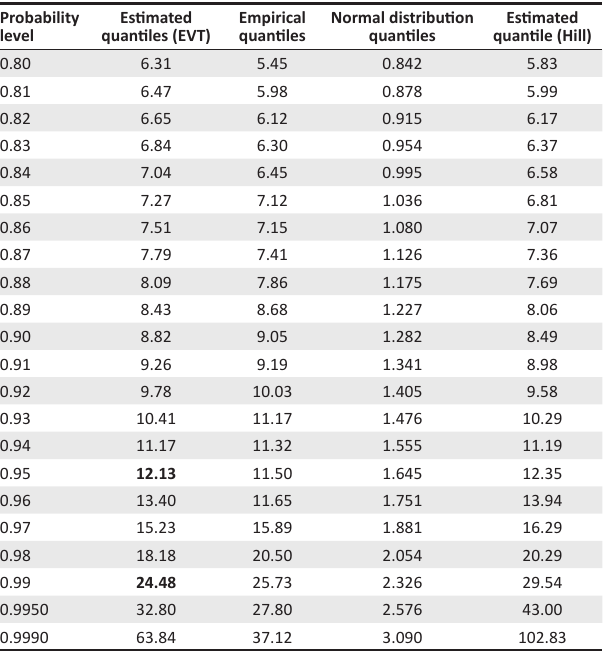
TABLE 7: South Africa – Estimated tail quantiles of the exchange market pressure index: 1999–2017. Probability Estimated Empirical Normal distribution Estimated level quantiles (EVT) quantiles quantiles quantile (Hill)